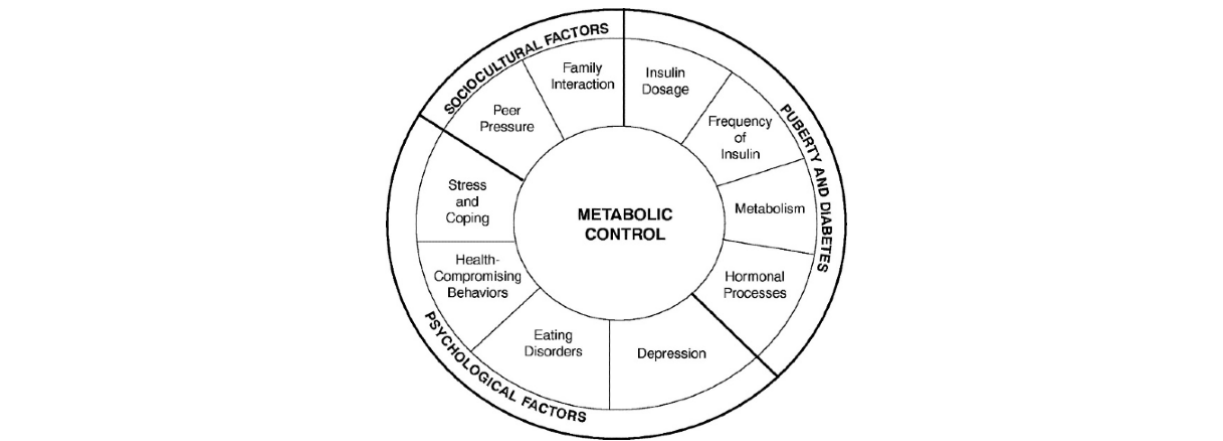
Figure 5. Influencing factors of